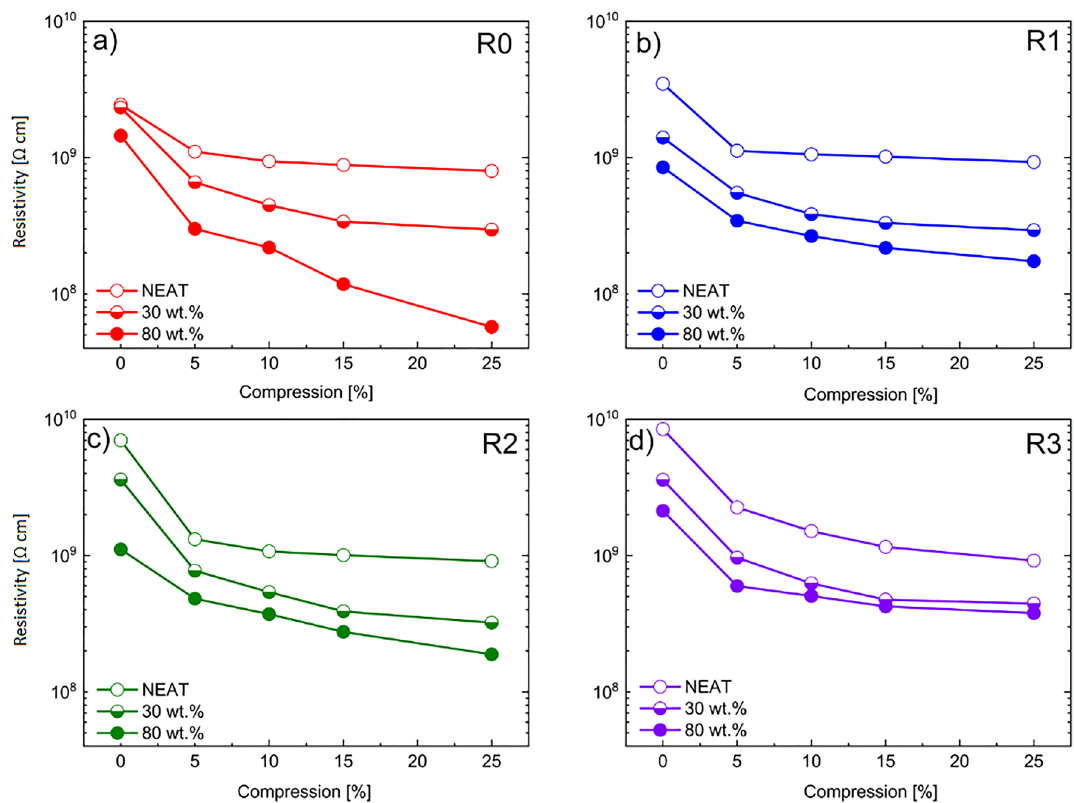
Figure 9. Resistivity dependences on the relative compression deformation of the neat TPUs (open symbols), 30 wt% filled TPUs (half up open symbols) and 80 wt% filled TPUs (solid symbols) for ( a ) IM/samples (red), ( b ) IM/one time recycling process (blue), ( c ) IM/two times recycling process (green), ( d ) IM/three times recycling process